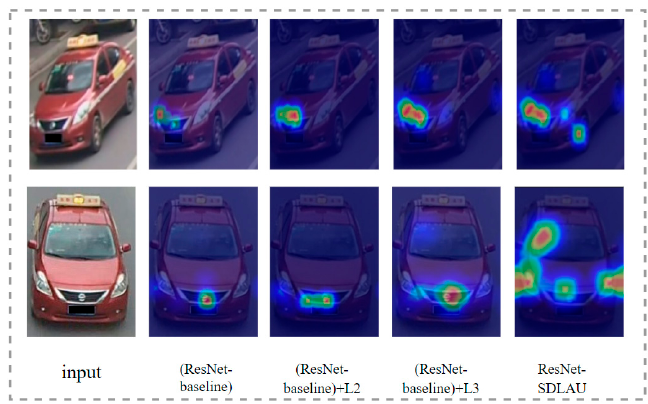
Figure 9. Vehicle feature visualization by di ff erent methods.